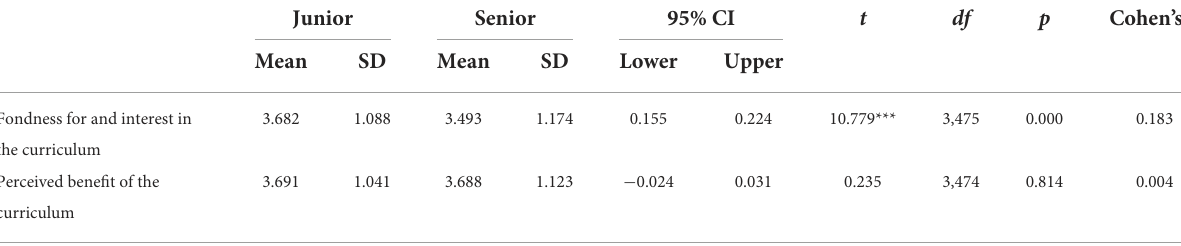
TABLE 6 Results of paired t -test between students’ perceptions of the junior and senior secondary curriculum. Junior Senior 95% CI